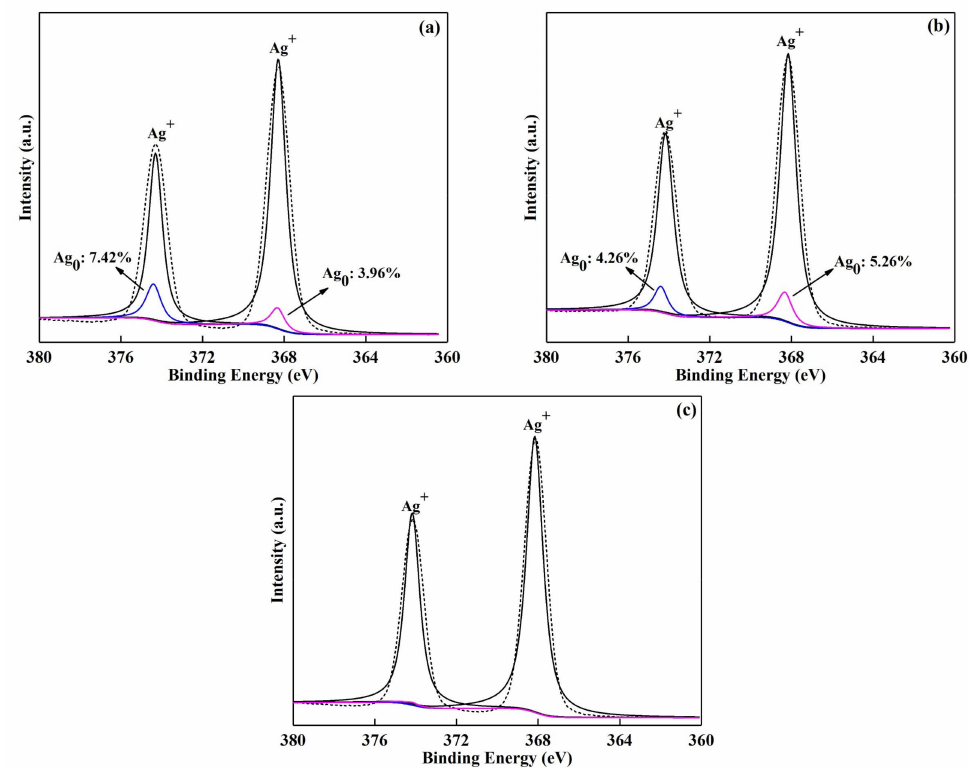
Figure 6. X-ray photoelectron spectra of Ag3d of the recycled photocatalysts, ( a ) Ag 3 PO 4 -SC; ( b ) CuBi 2 O 4 /Ag 3 PO 4 -SC; ( c ) CuBi 2 O 4 /Ag 3 PO 4 -SC (1.06 mM H 2 O 2